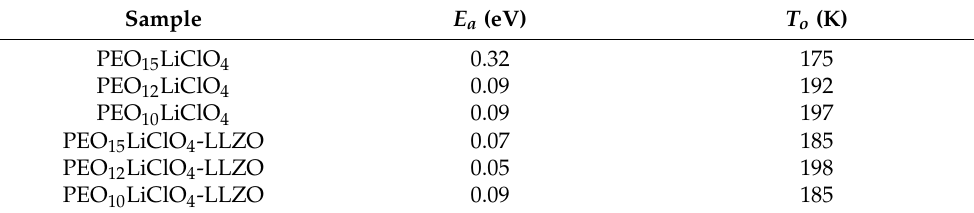
Figure 6. Ionic conductivity vs. 1000 T − 1 for ( a ) PEO n -LiClO 4 and ( b ) PEO n LiClO 4 -LLZO films. Filled circles represent the experimental data and the solid lines represent the VTF fit. Table 2. Activation energy and T o of PEO n LiClO 4 and PEO n LiClO 4 ‐ LLZO obtained fitting the temperature ‐ dependent ionic conductivity with VTF model.